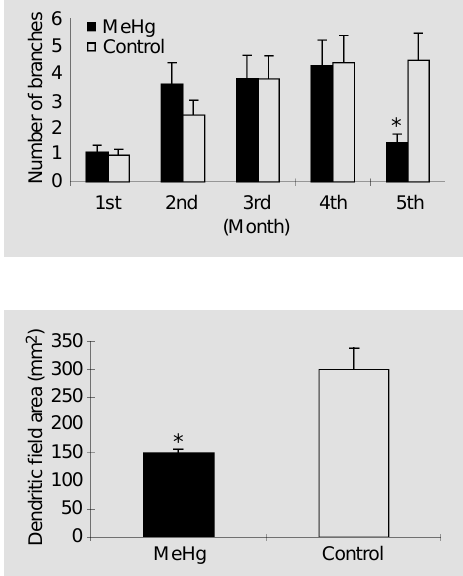
Figure 1 - Number of dendritic branches of white matter NADPHd-positive neurons in the striate cortex of the adult cat 6 months after intoxication. Note that the number of more distal dendritic branches is significant- ly decreased in the treated ani- mal compared to the control one (*P<0.05).